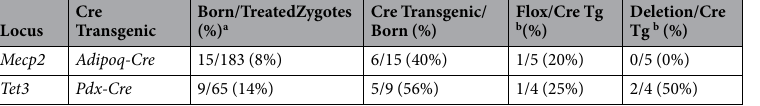
Table 5. Direct Production of Cre/lox Mice by Sequential Electroporation. a Yield of mice (born/treated zygotes). b Samples that were not amplified by PCR were excluded because they could have contained chromosomal deletions. Tg, Transgenic. Detailed data are shown in Table